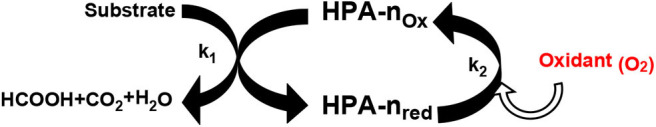
The redox cycle of the catalyst H5PV2Mo10O40.